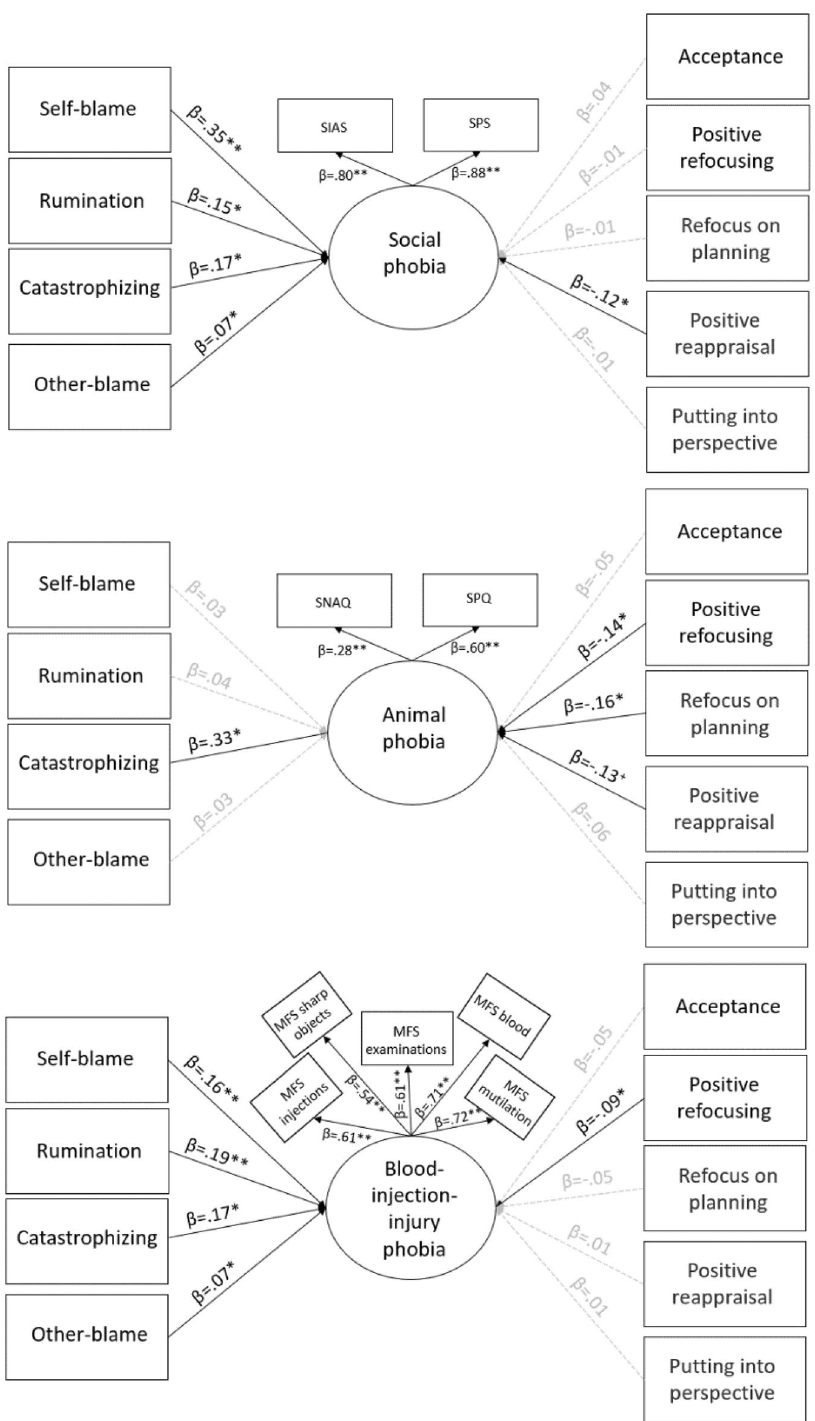
Figure 2. The pattern of emotion regulation strategies behind various phobias. All paths included in the analysis are displayed. All reported estimates are the maximum likelihood standardized point estimates. Statistically significant unstandardized point estimates are highlighted in black ( + p = 0.05; *p < 0.05; **p < 0.001). Grey lines indicate a nonsignificant pathway. SPS Social Phobia Scale, SIAS Social Interaction Anxiety Scale, SNAQ Snake Phobia Questionnaire, SPQ Spider Phobia Questionnaire, MFS Medical Fear